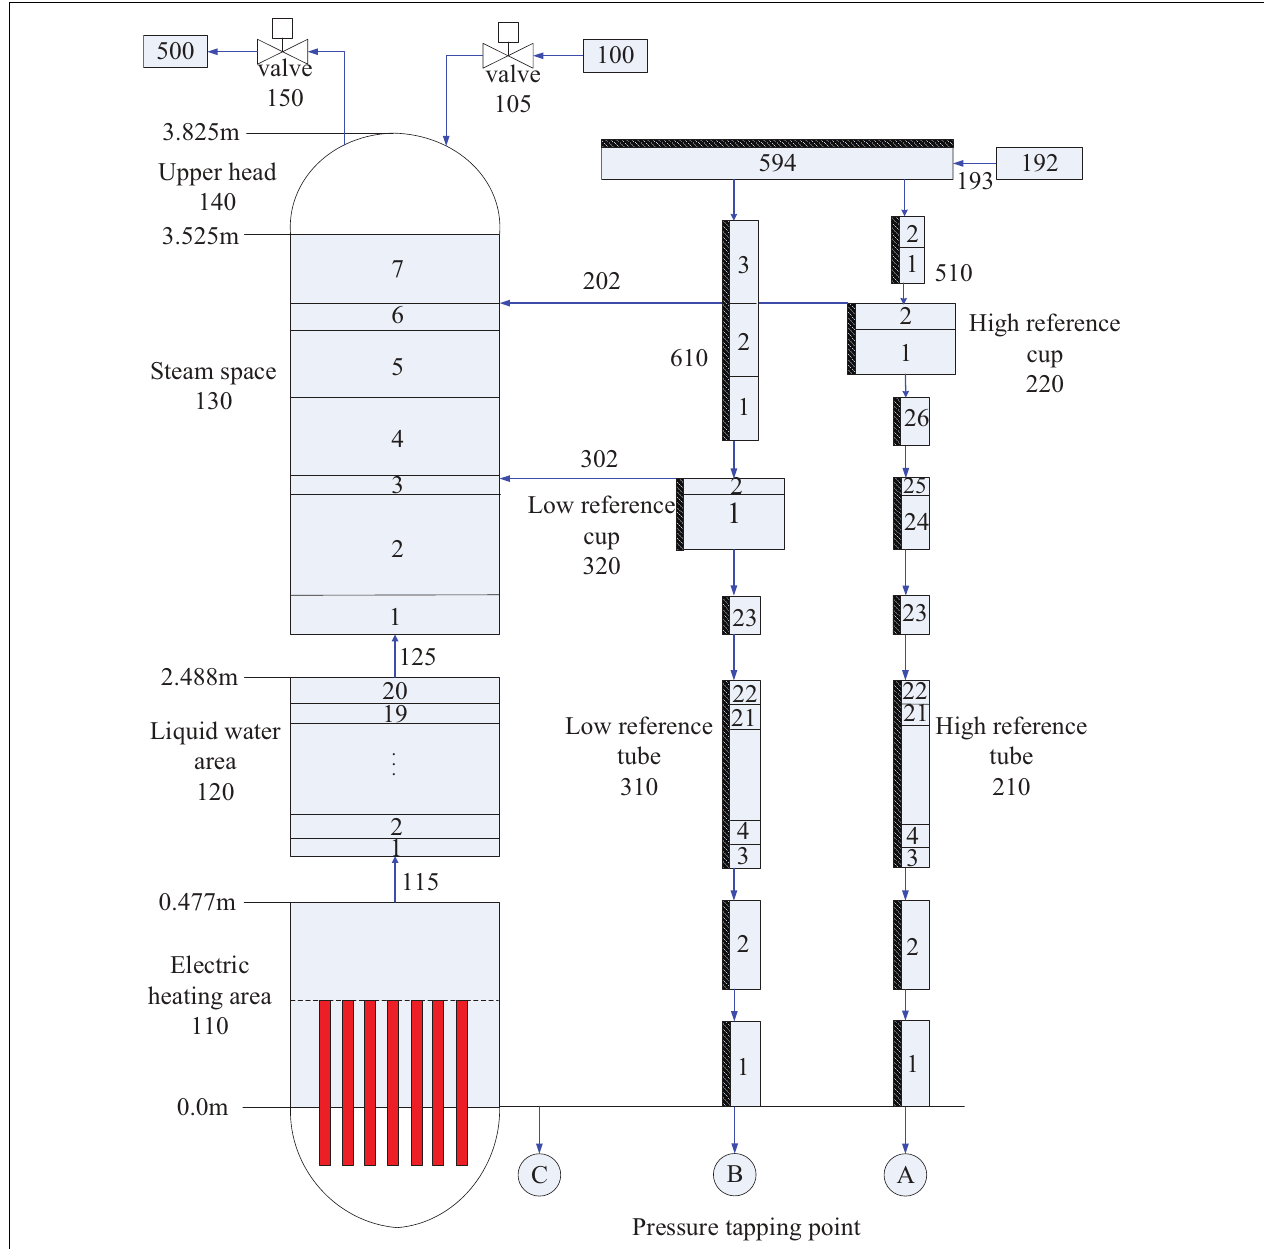
FIGURE 2 | RELAP5 nodal model of the double reference tube level gauge.